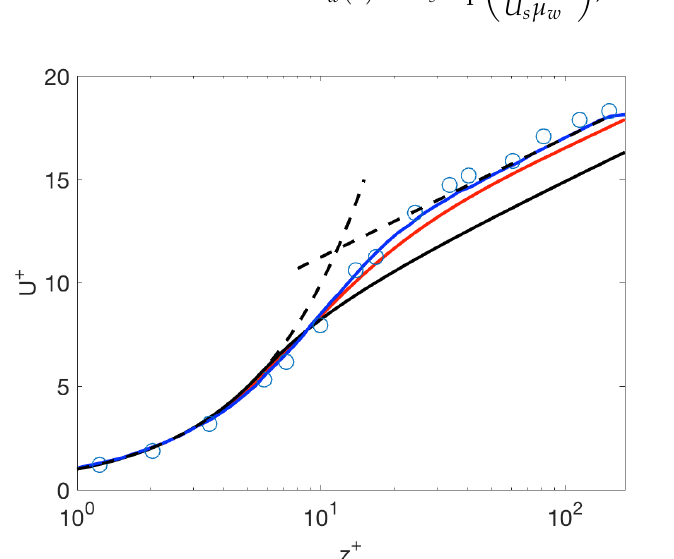
Figure 2. Colour online. Normalised velocity profiles, in the air, against the normalised z coordinate. Blue: direct numerical simulations of [15]. ◦ [14] experimental data. Red: [11] profile. Black: lin-log profile. Discontinuous line: law of the wall.